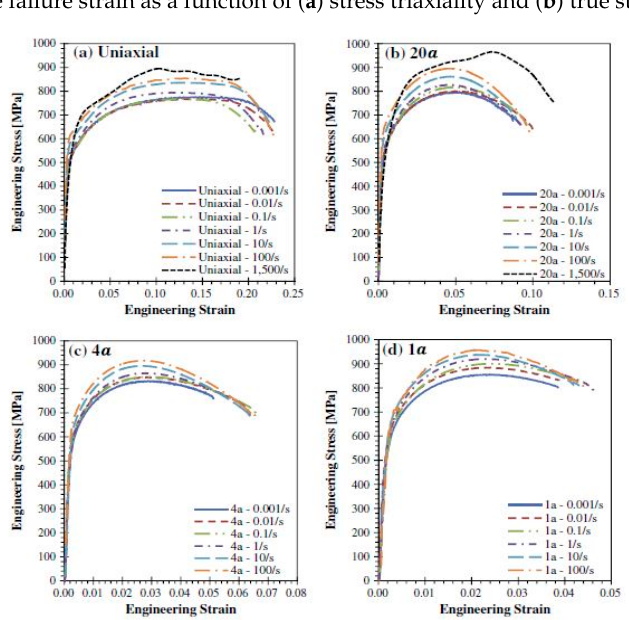
Figure 31. Stress strain curve of DP780 steel for ( a ) uniaxial test, ( b ) 17.5-mm notch specimen, ( c ) 3.5-mm notch specimen, and ( d ) 1-mm notch specimen [175] .